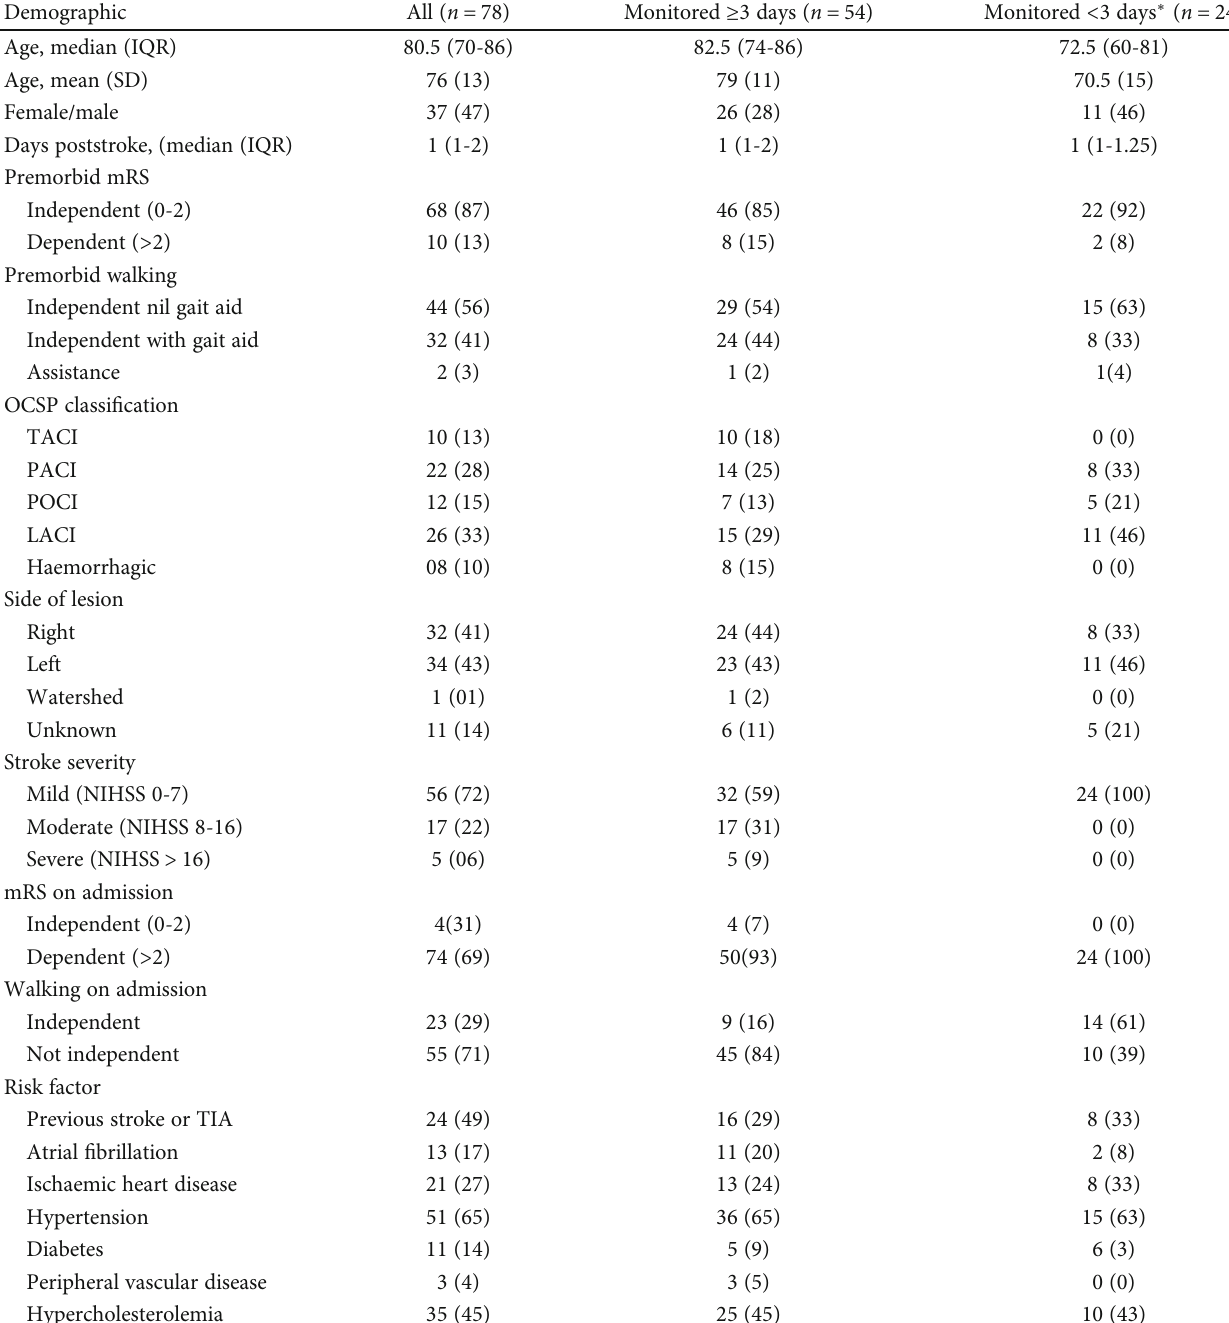
Table 1: Participant characteristics and stroke